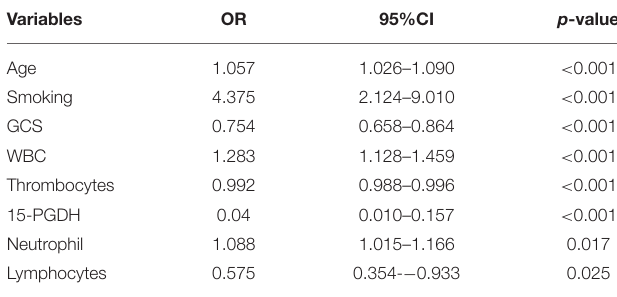
TABLE 1 | Patient characteristics with SAP and Non-SAP with stroke. TABLE 2 | Factors contributed to SAP by the multivariate